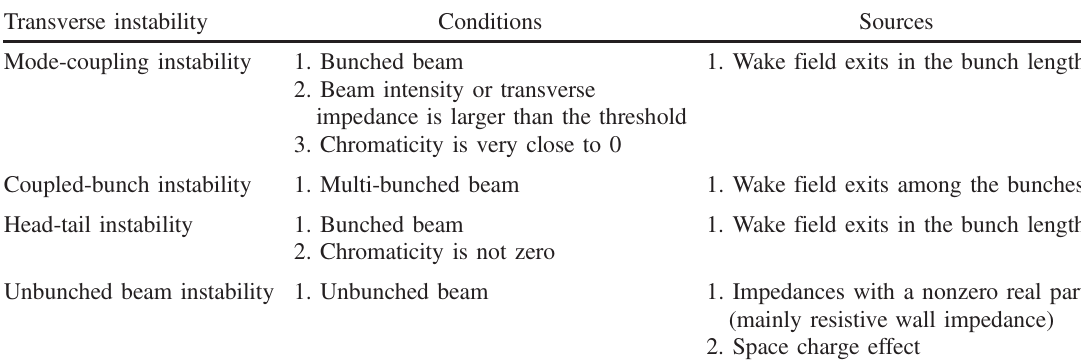
TABLE III. Sources and conditions for different transverse instabilities.